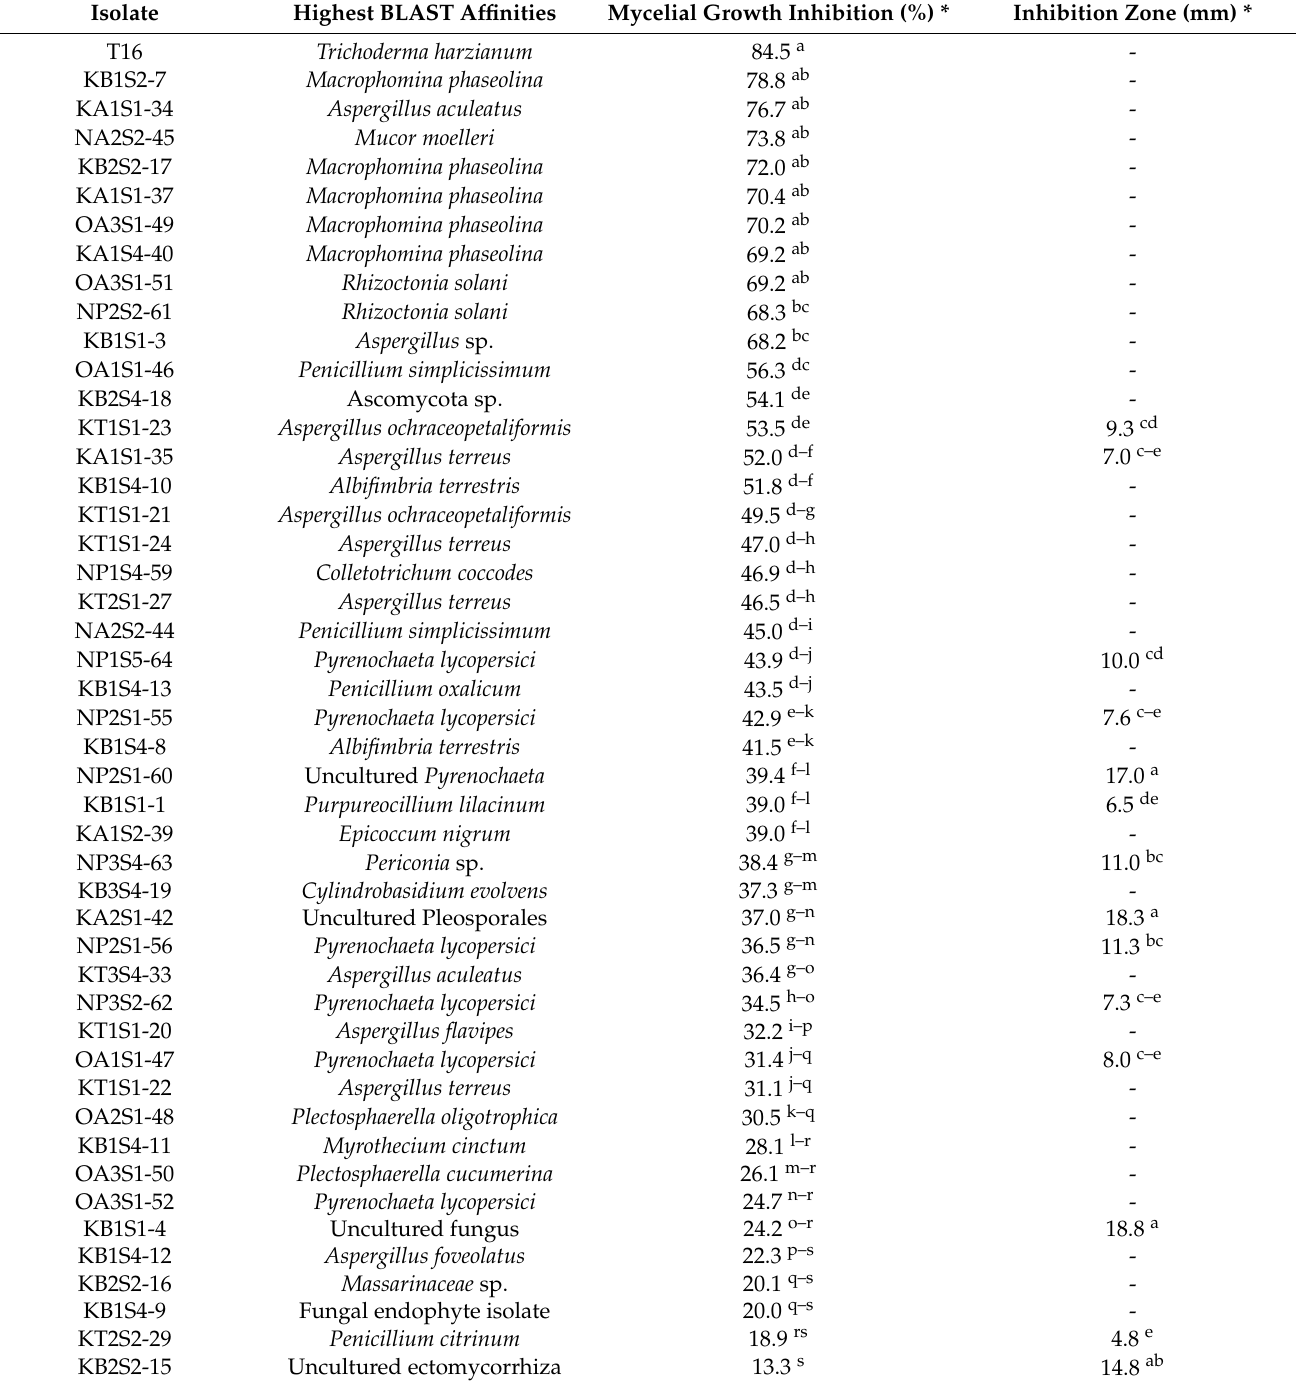
Table 2. Mycelial growth inhibition of P. infestans and inhibition zones caused by endophytic fungi (arranged in descending order in terms of their mycelial growth inhibition) in dual